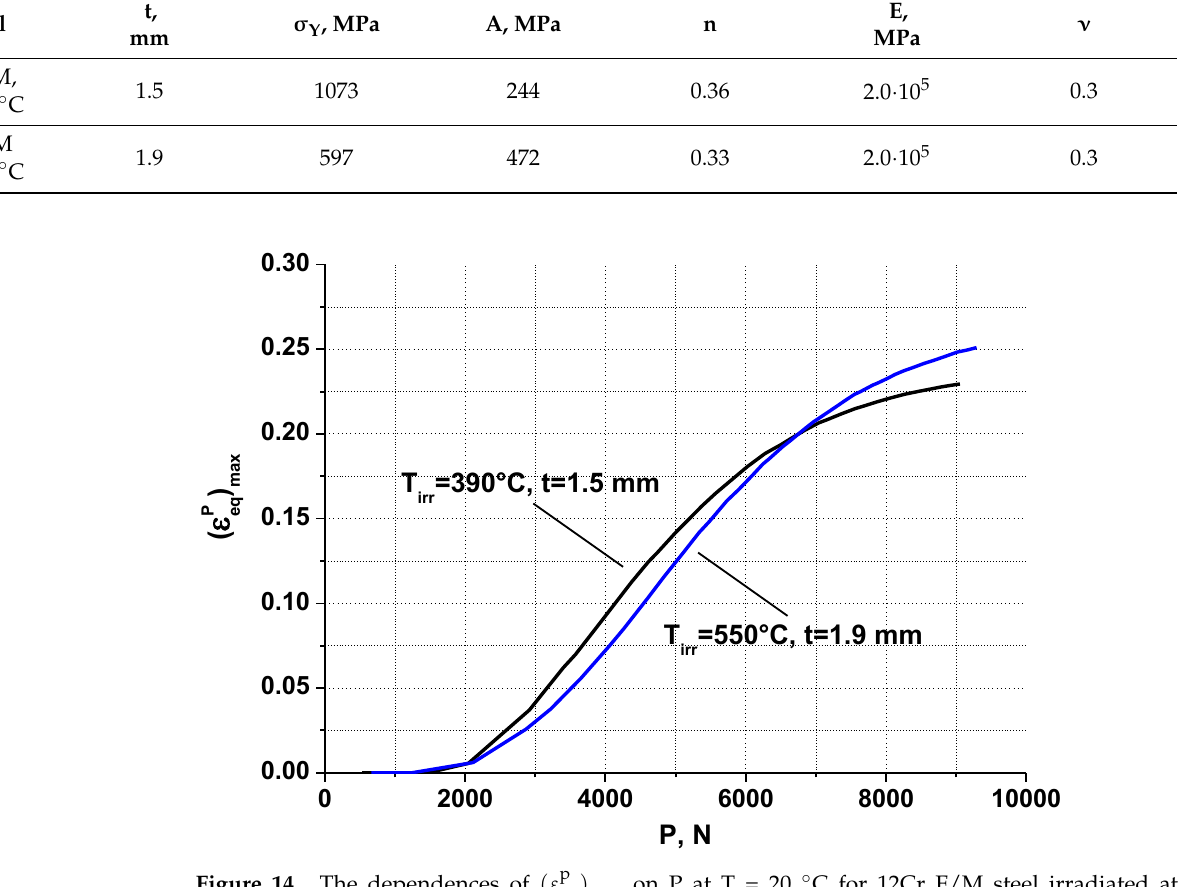
Figure 14. The dependences of (ε eqp ) max on P at T = 20 °C for 12Cr F/M steel irradiated at T irr = 390 °C and 550 °C.